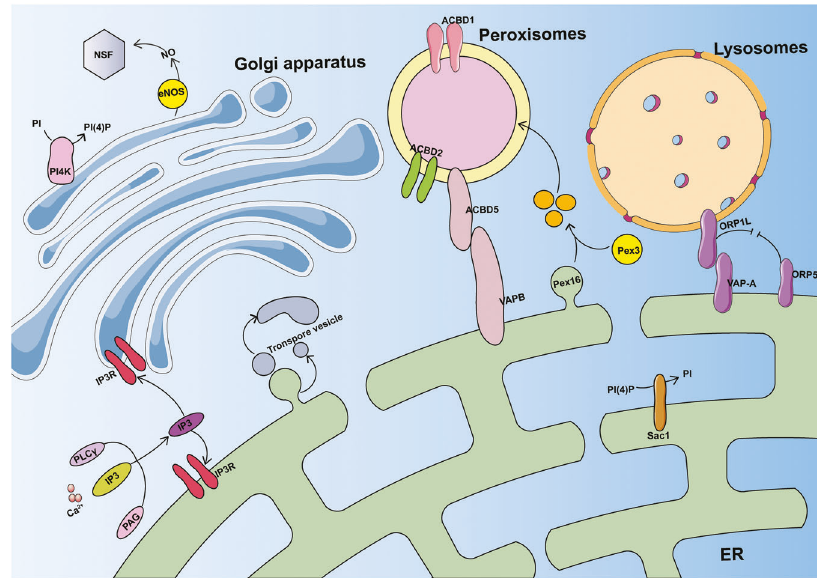
Fig. 2 Crosstalk between the ER and other organelles. ORP1L contacts VAP-A to form ER lysosome contact sites under low cholesterol conditions. Pex16 containing vesicles derived from the ER, and Pex3 containing vesicles from the mitochondria can fuse and mature into peroxisomes. VAPA/B and ACBD5 constitute the ER-peroxidase contact site. ENOS closely associates with NSF and reduces the rate of protein transport from the Golgi to the plasma membrane. Ca 2 + is released from intracellular stores through the binding of IP3 to